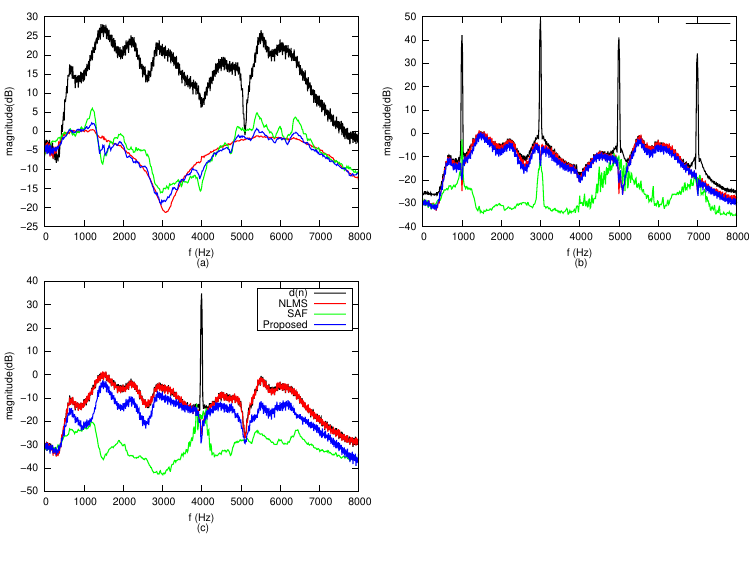
Figure 9. Test case 2: spectrum for noise to reduce d ( n ) and residual signal e ( n ) for the three tested algorithms. White noise ( a ), multi-tonal ( b ), mono-tonal ( c ). The legend is the same for all sub